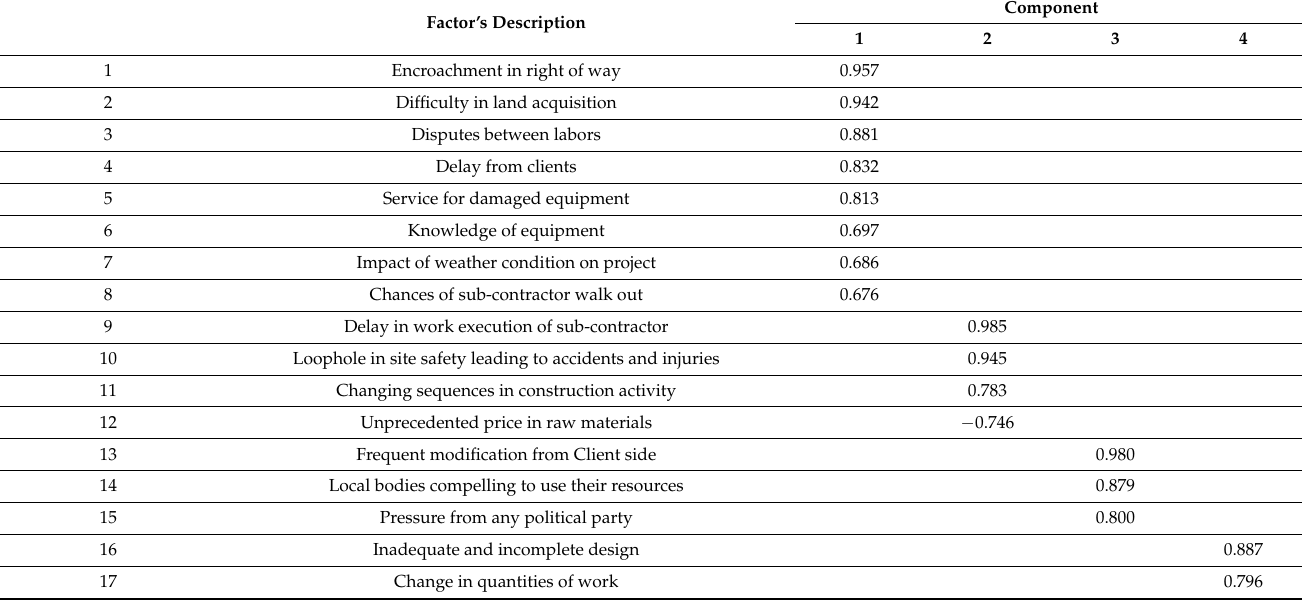
Table 3. Rotated Component matrix for categorization of